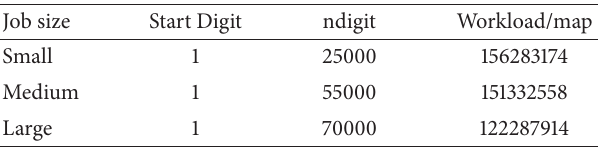
Table 5: The configuration details for BBP, including start digit, end digit, and the workload per map